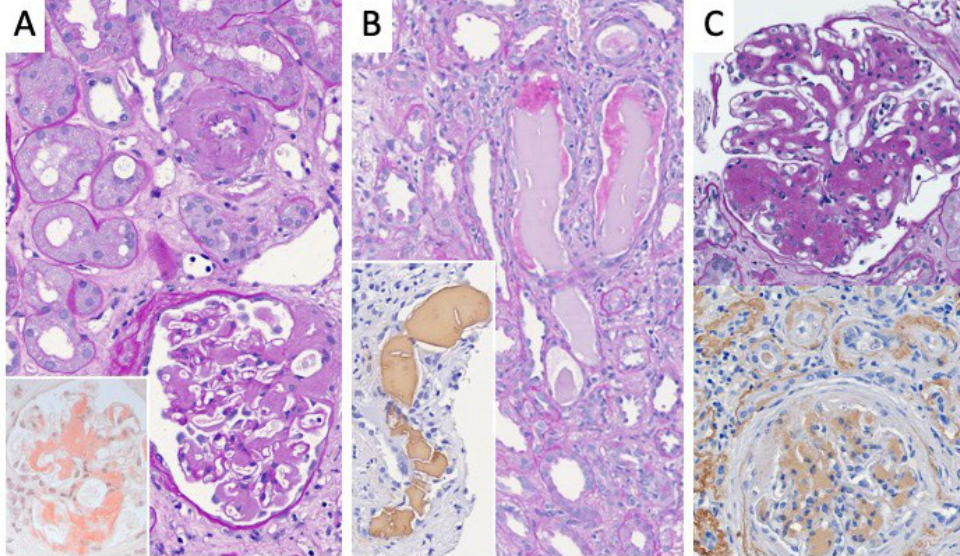
Figure 2. Examples of findings in kidney biopsies from patients with paraproteinemia. ( A ) Amyloidosis with the typical homogenous depositions in the walls of arteries (upper part) and glomerular mesangium (lower part), showing positivity in the Congo-red stain (inlay). ( B ) Myeloma cast nephropathy with proteinaceous intratubular material accompanied by cell proliferation and light-chain restriction, as demonstrated by immunohistochemistry (inlay, lambda). ( C ) Light-chain deposition disease (LCDD) with nodular expansion of the mesangium resembling diabetic nodular glomerulosclerosis Kimmelstiel–Wilson in conventional microscopy (upper half). Immunohistochemistry revealing depositions of light chains, typically kappa (lower half). ( A – C ) PAS stains, original magnification 40×.